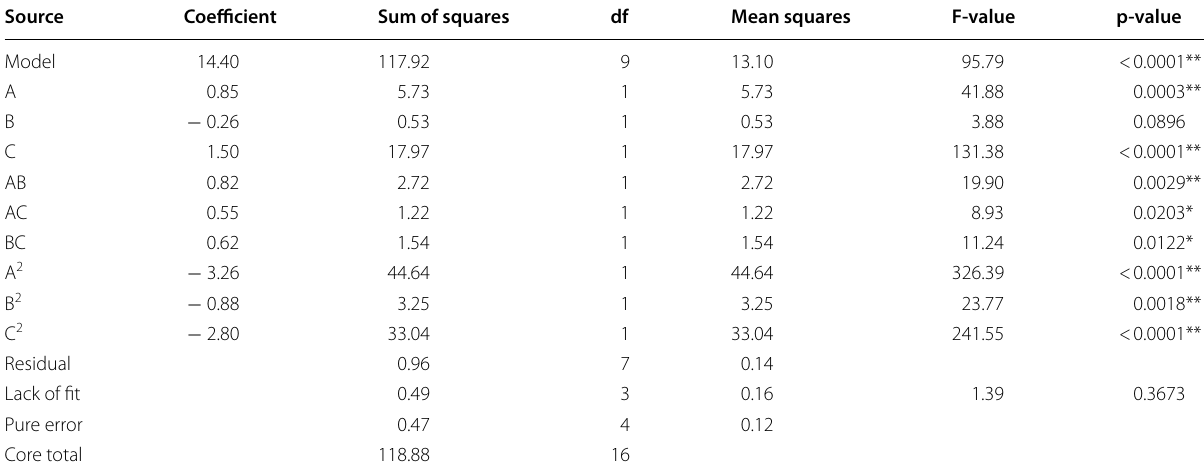
Table 2 Box-Benhnken experiment results for significant factors